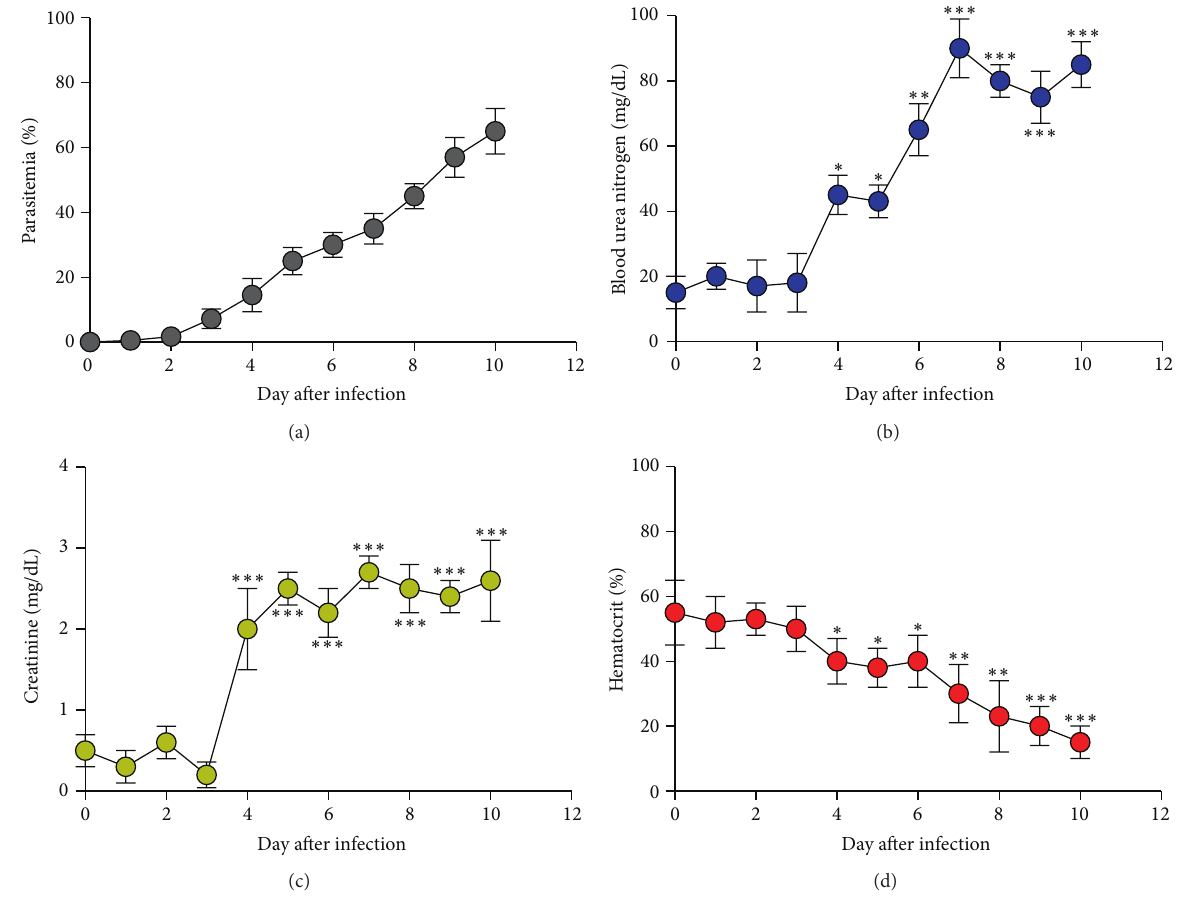
Figure 1: Renal damage and hemolysis induced by Plasmodium berghei infection. ICR mice (5 mice) were inoculated with 1 × 10 7 parasitized erythrocytesofPbANKAbyintraperitonealinjection.(a)Parasitemia,(b)BUN,(c)creatinine,and(d)hematocritlevelsweredailymonitored. Results were expressed as mean ± SEM. ∗ 𝑃 < 0.05, ∗∗ 𝑃 < 0.01, and ∗∗∗ 𝑃 < 0.001, compared to day 0 after